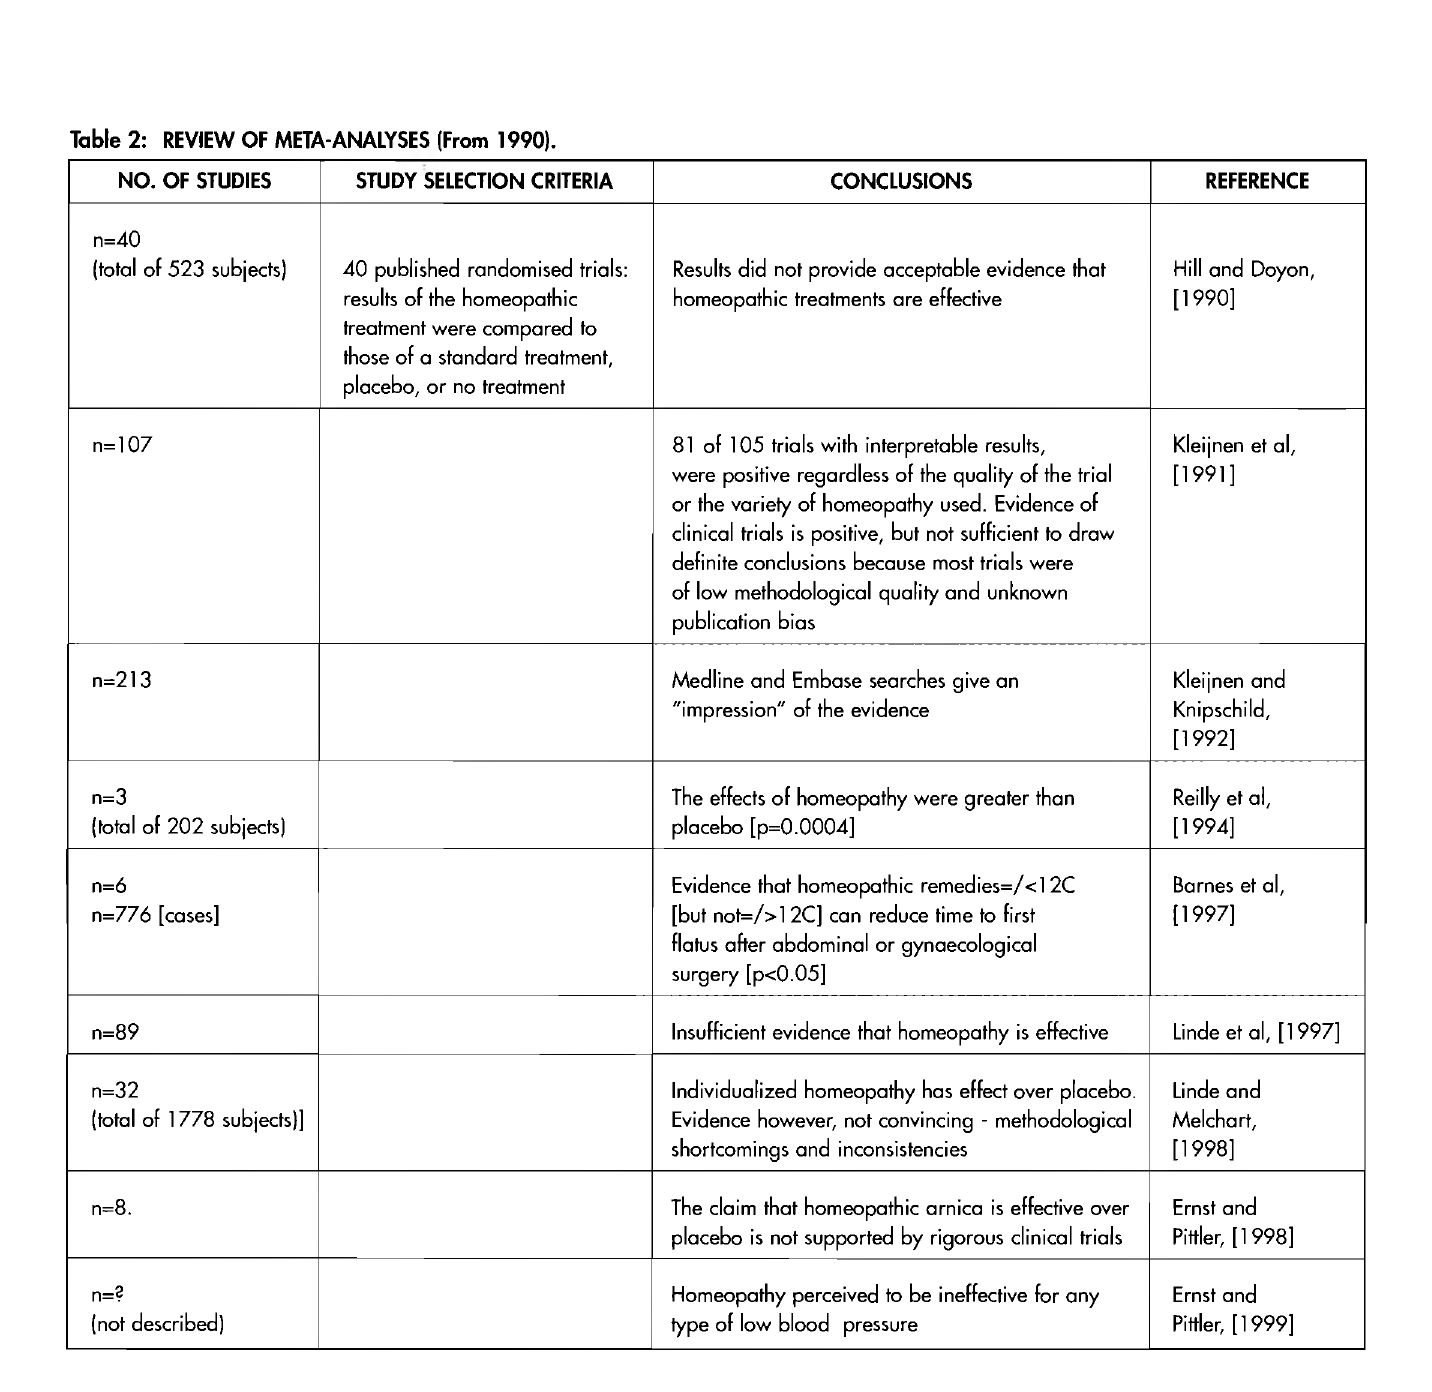
Table 2: REVIEW OF META-ANALYSES (From